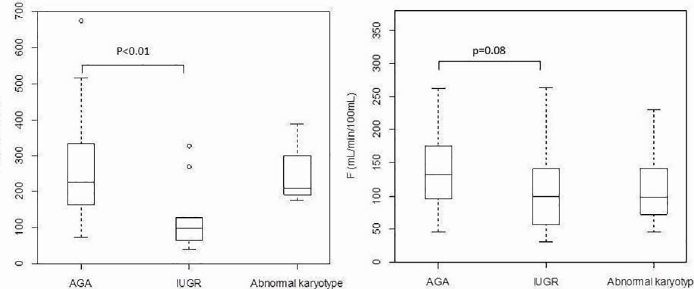
Fig 5. Box plot of placental perfusion F total (mL/min) and F (mL/min/100mL) as a function of fetus group (appropriate for gestational age birthweight fetuses AGA; intrauterine growth restriction fetuses IUGR